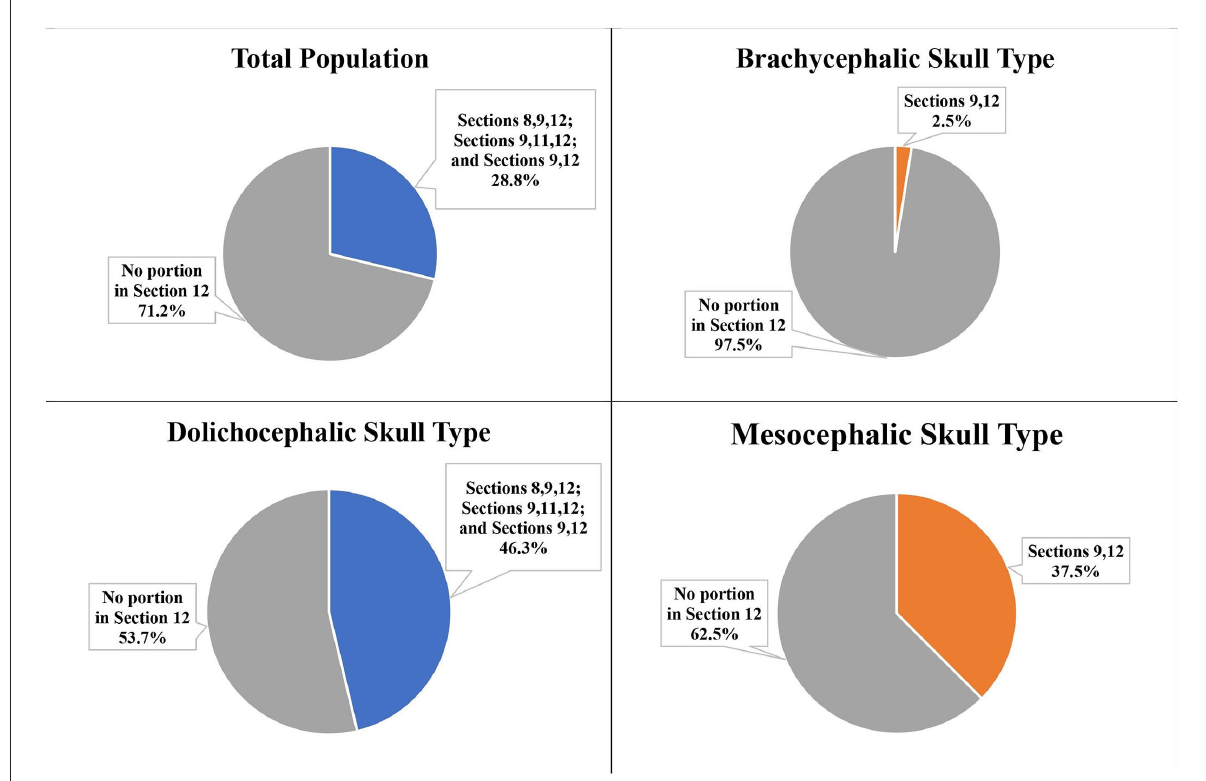
FIGURE10 IOC fully or partially in Section 12 at the distal root of the P4 for the total population and the three different skull